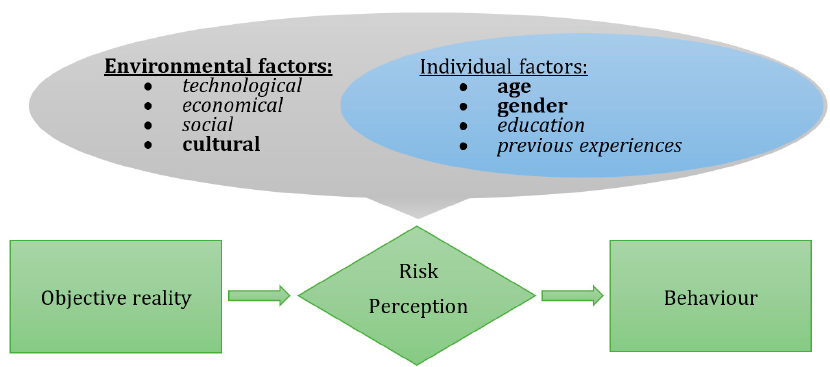
Figure 1. Factors affecting individual behaviour through perception.